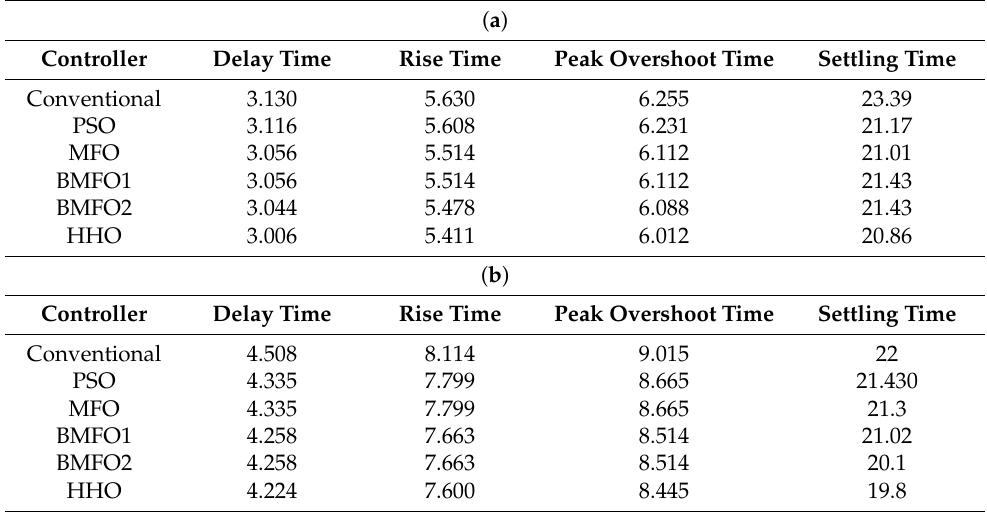
Table 13. ( a ). Graphanalysis of GENCOs to Distribution Companies (DISCOs) generation response of Area1 with various controllers under bilateral contract. ( b ). Graph analysis of DISCOs to GENCOs generation response of Area1 with various controllers under bilateral